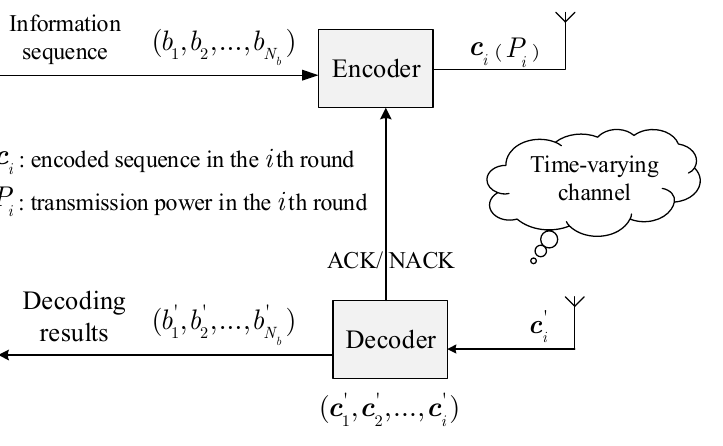
Figure 3. The transmission model of IR-HARQ.